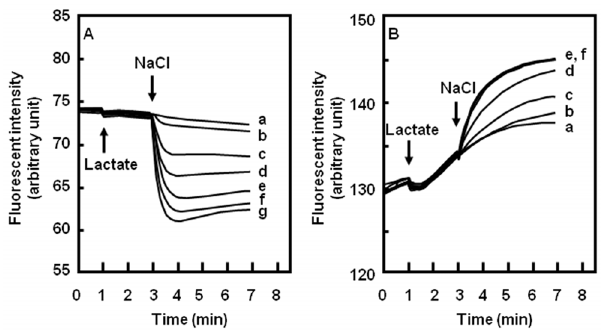
Figure 2. Salt concentration-dependent fluorescent dye efflux via PdrM. DAPI efflux activity (A). The concentration of NaCl or LiCl is (a) 0 mM, (b) 1 mM, (c) 10 mM, (d) 30 mM, (e) 50 mM, (f) 80 mM, and (g) 100 mM. Acriflavine efflux activity (B). The concentration of NaCl or LiCl is (a) 0 m M, (b) 10 m M, (c) 100 m M, (d) 1 mM, (e) 10 mM, and (f) 20 mM. Acriflavine fluorescence was quenched in cells because of its